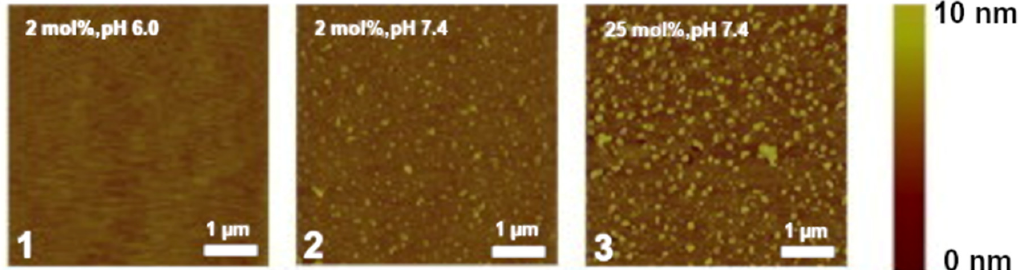
Figure 5. Snapshots of experiments on mixed lipid monolayers, containing different mol % of 1-stearoyl-2-oleoyl- sn -glycero-3-phosphocholine (SOPC) and PI(4,5)P2, while exposed to calcium.